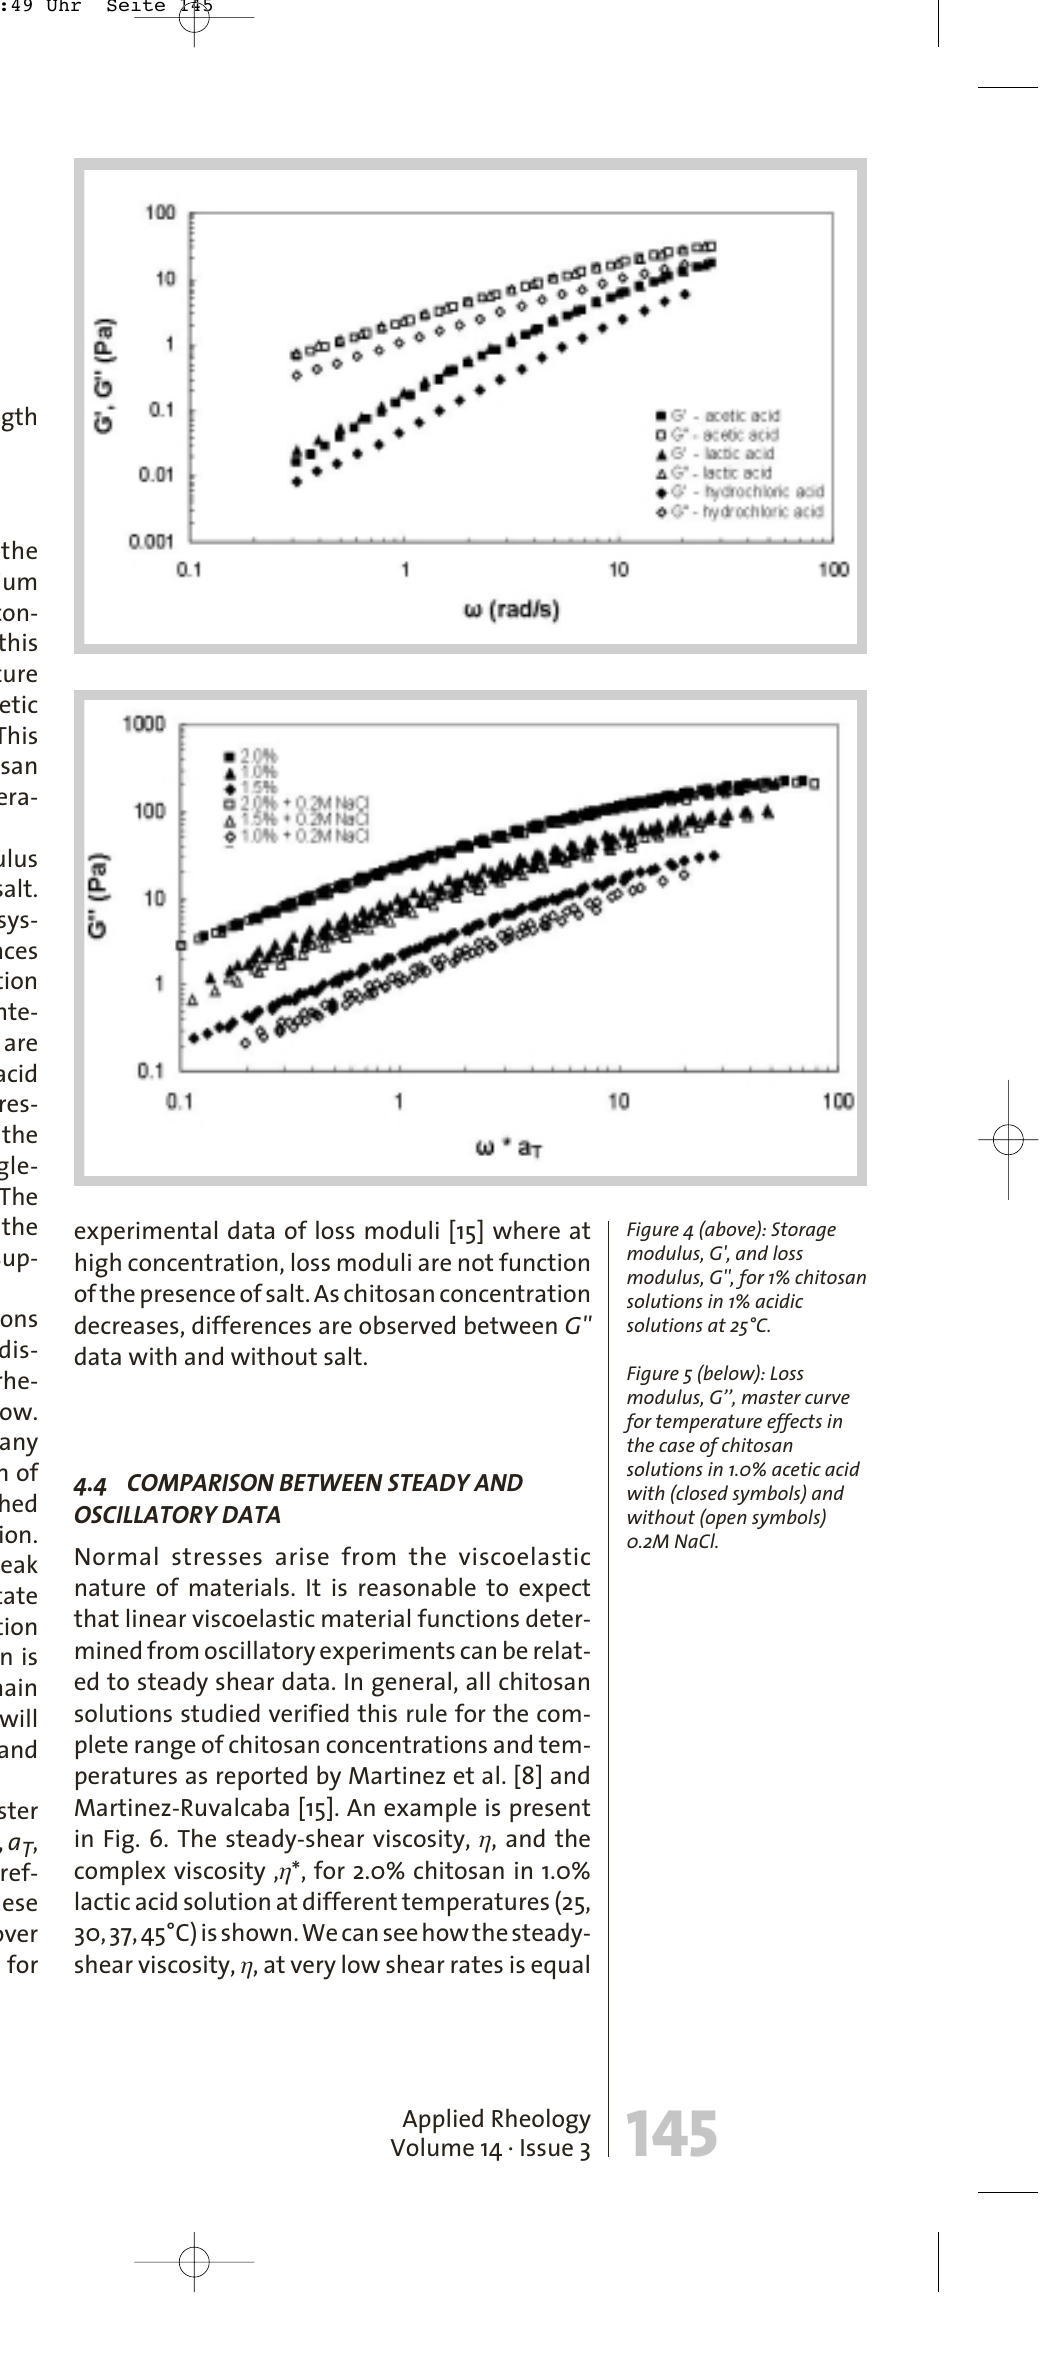
Figure 4 (above): Storage modulus, G', and loss modulus, G'', for 1% chitosan solutions in 1% acidic solutions at 25°C. Figure 5 (below): Loss modulus, G’’, master curve for temperature effects in the case of chitosan solutions in 1.0% acetic acid with (closed symbols) and without (open symbols) 0.2M